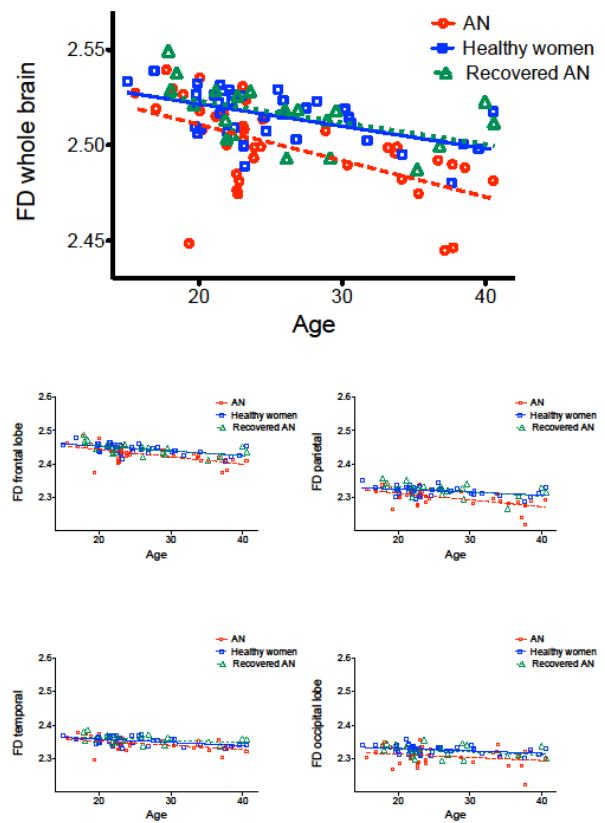
Figure 4. Correlations between whole-brain (cortical ribbon) and lobar FD and age in the three groups.